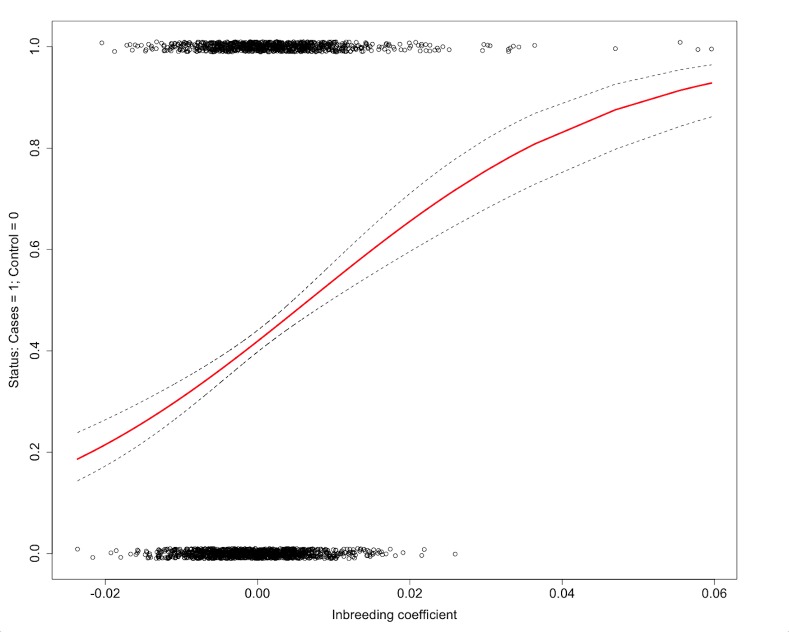
Regression slope of inbreeding coefficient F III on disease status (including confidence interval).The inbreeding coefficient F III as a continuous variable is used in a generalized linear model as an explanatory variable on the disease status of the study participants defined as the binary response (0/1).